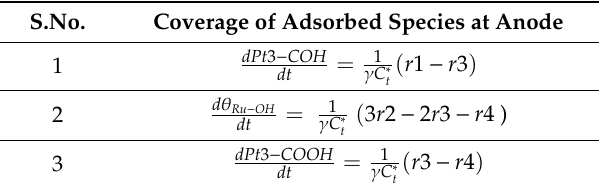
Table 2. Equation for coverage of adsorbed species at the anode. S.No. Coverage of Adsorbed Species at